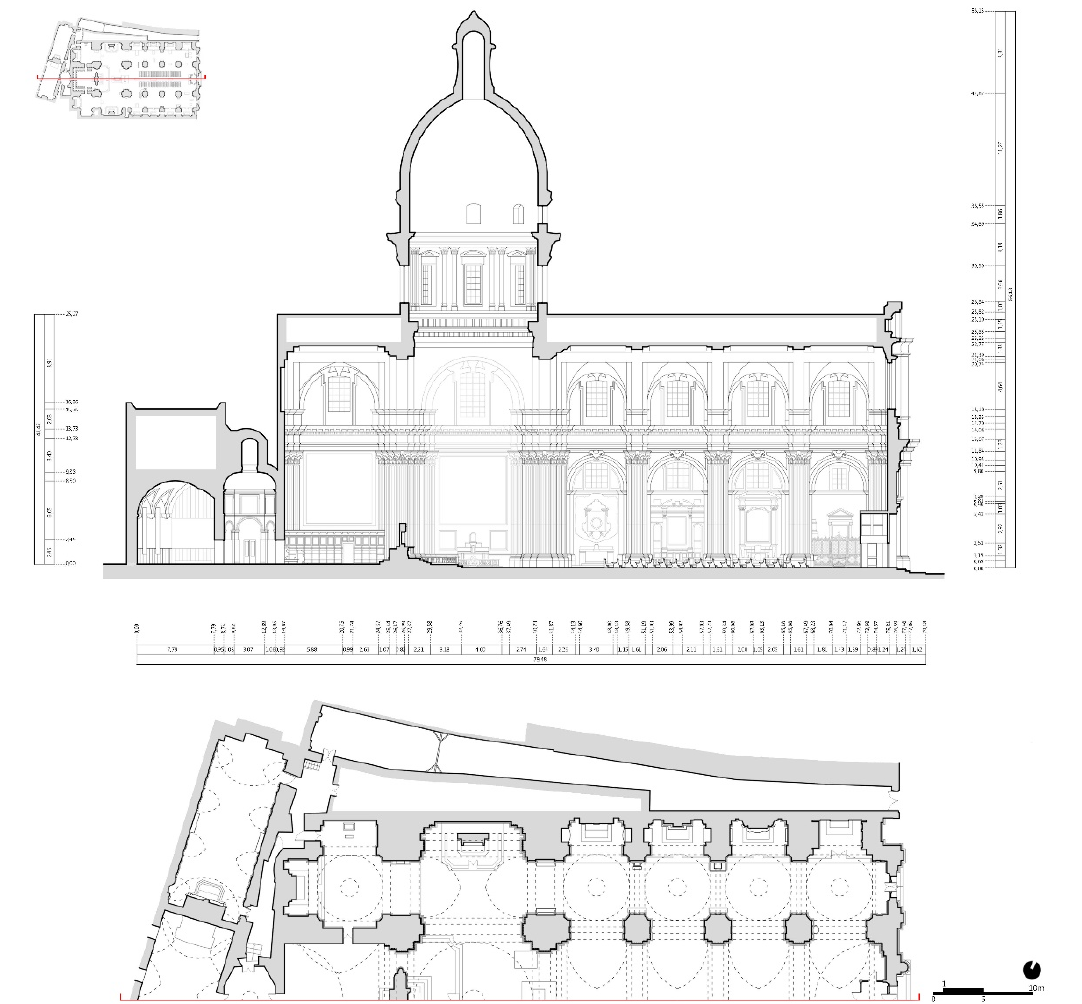
Figure 13. Graphic elaborations of the Church of Santa Maria degli Angeli based on the point